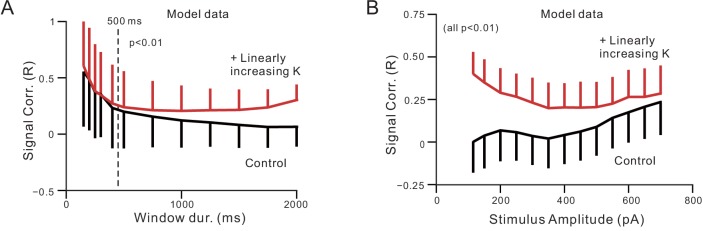
Computation models incorporating an ERG-like K+ conductance that increases during depolarizing step responses reproduces changes in signal correlation.(A) Simulations performed analyzing different window durations with linear K included (red plot) and with no additional ERG-like linear K current (black plot). Inclusion of linear K current had no effect on the signal correlation apparent in short-duration responses (<500 ms) but decreased response correlation in longer duration responses (at 500 ms: p=1.922E-8, T = 5.624, two sample t-test). (B) Plot of signal correlations vs. depolarizing step amplitudes in model simulations with (red plot) and without a linear K current (black plot). All corresponding pairs of points statistically different, p<0.01; at 700 pA (highest amp): p<1E-6, T = 50.242, paired t-test. Error bars represent SD.